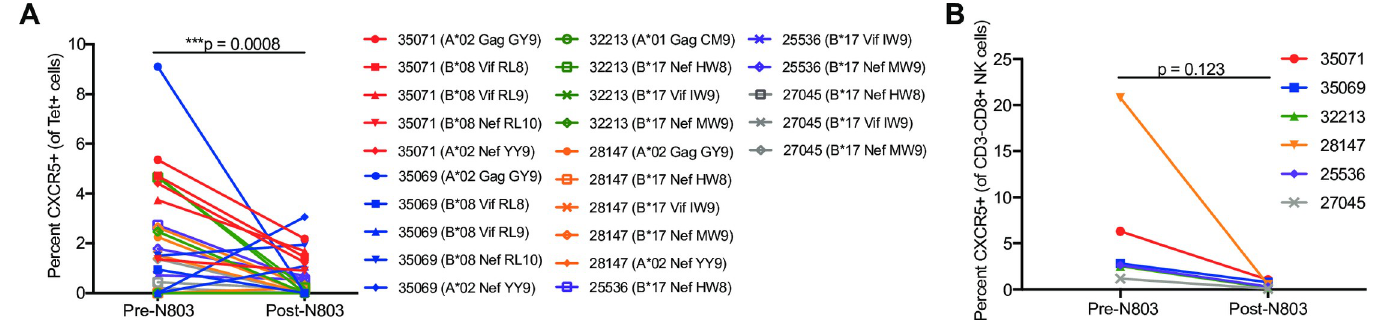
Fig 7. Decreased expression of CXCR5 on SHIV-specific CD8+ T cells and NK cells after N-803 in lymph nodes. (A) CXCR5 staining on SHIV-specific CD8+ T cells and (B) NK cells in peripheral lymph nodes before and after N-803 treatment. P values were calculated using a linear mixed effects model ( A ) and a paired t-test ( B ). � , P < 0.05; �� , P < 0.01; ��� , P < 0.001.